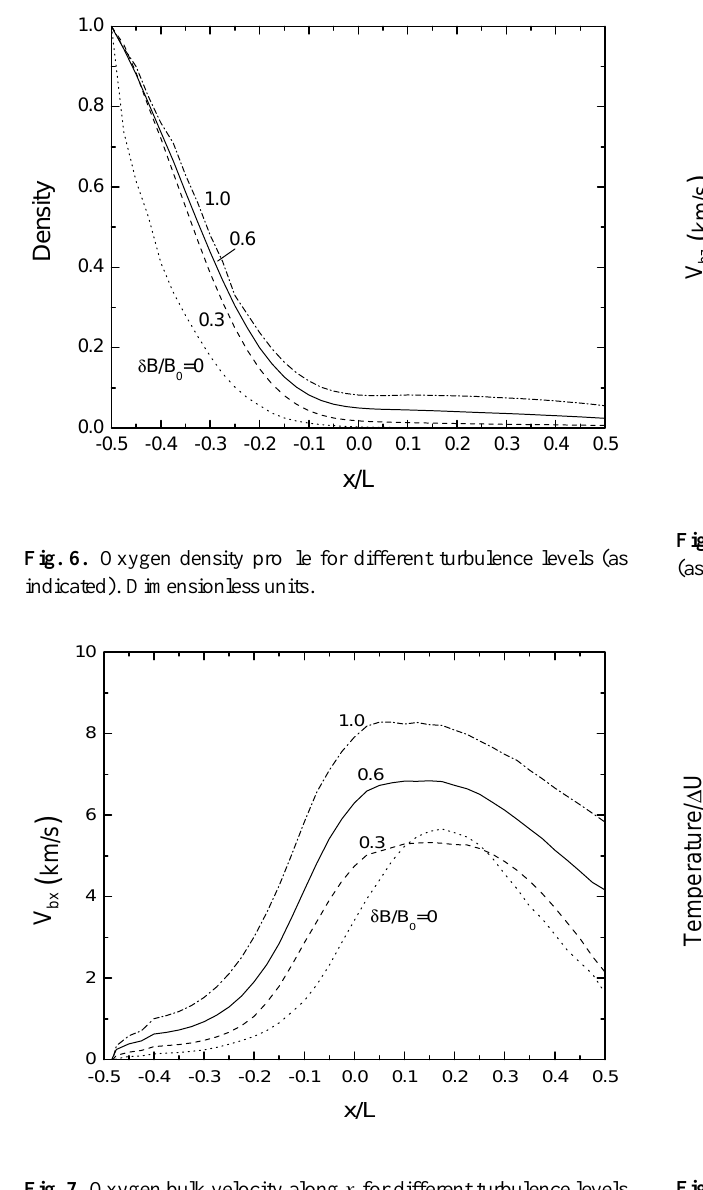
Fig. 7. Oxygen bulk velocity along x for different turbulence levels (as indicated).